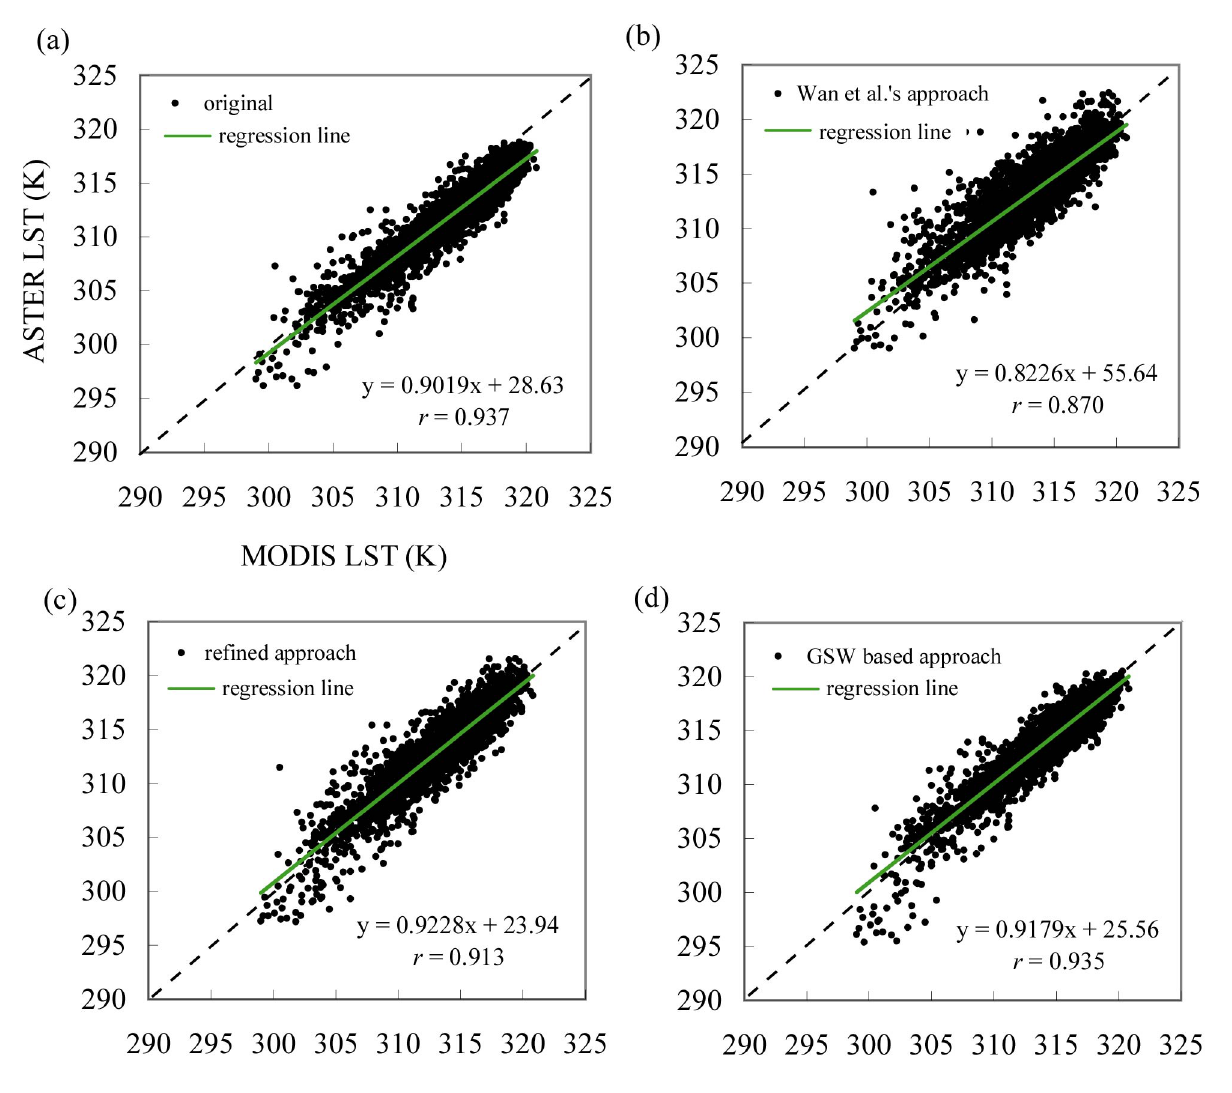
Figure 2. Scattergram of MODIS LST versus scaled ASTER LST with terrain correction for the cases (a) The original MODIS MOD11_L2 LST, (b) The MODIS LST corrected using the Wan et al’s approach, (c) The MODIS LST corrected using the refined approach, and (d) The MODIS LST corrected using the GSW algorithm based